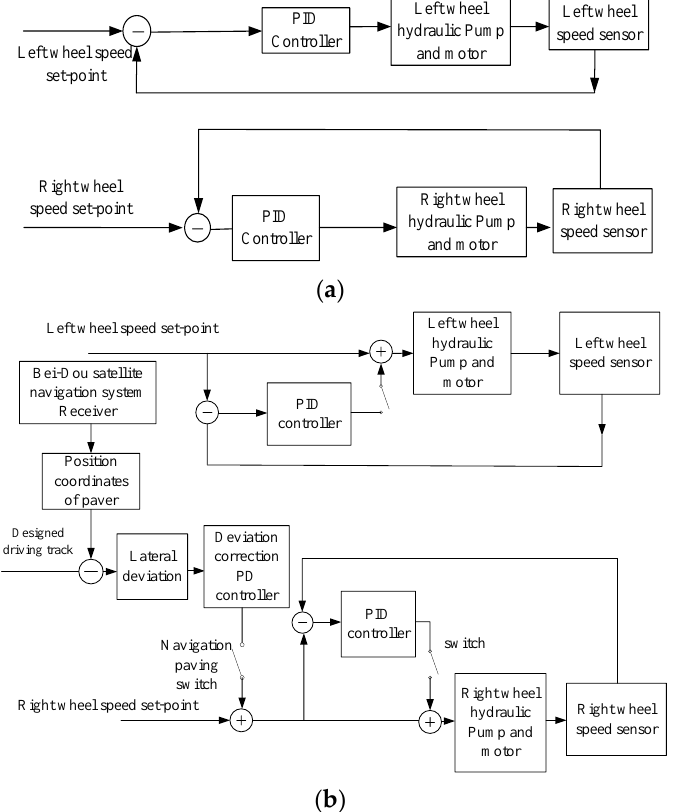
Figure 2. Travelling control scheme of paver. ( a ) Current travelling control scheme. ( b ) New control scheme.